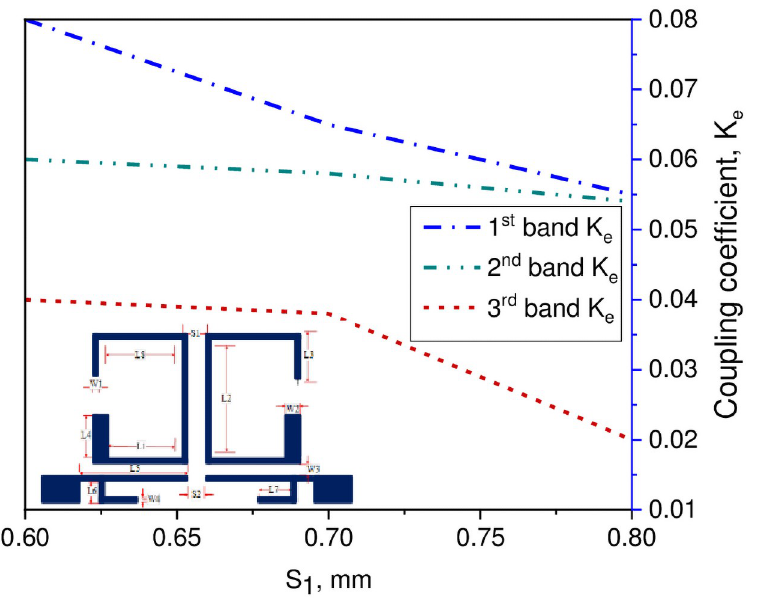
Fig 6. Graph of coupling coefficient with S 1 gap.